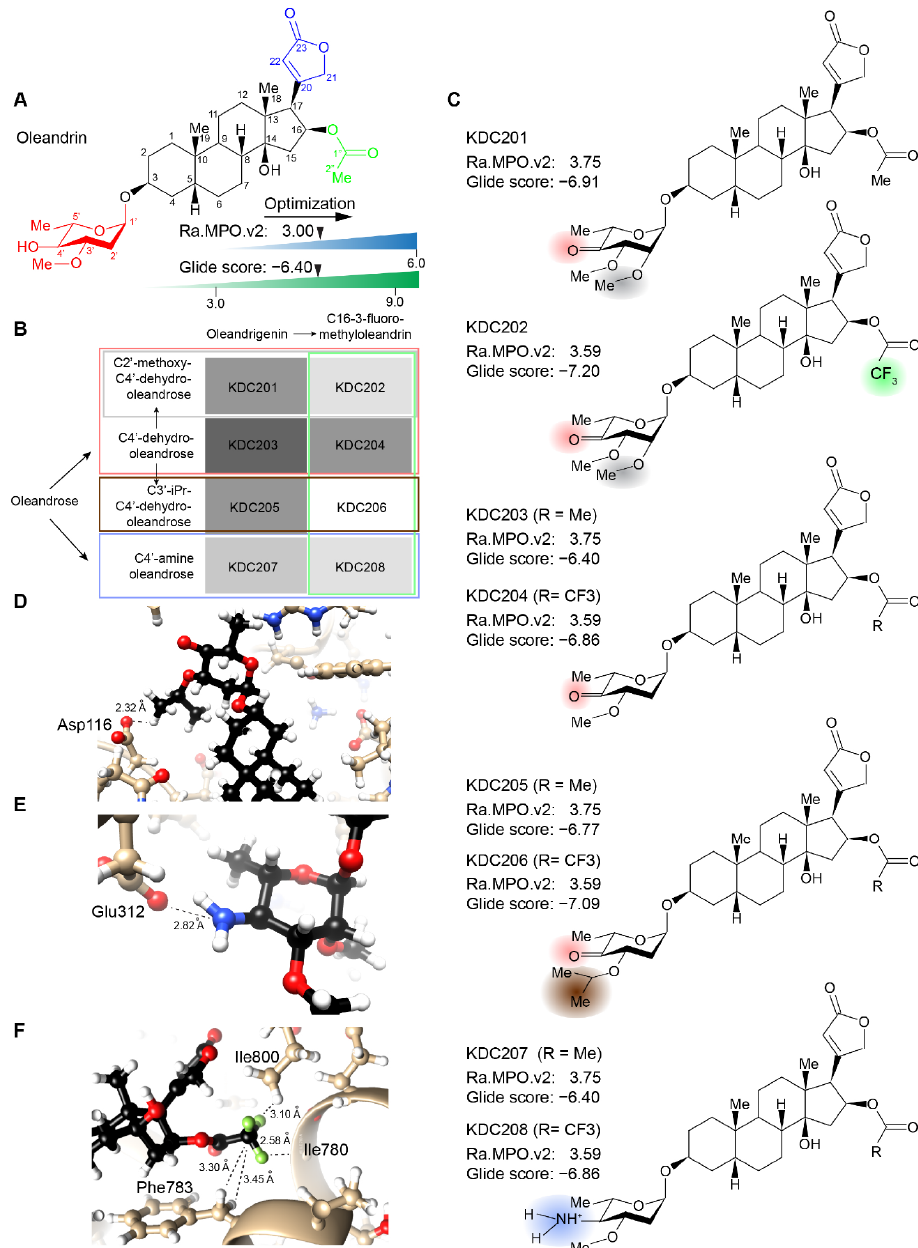
Figure 4. Features of chemically accessible Scaffold 4 derivatives-of-interest. ( A ) Chemical structure and reference Rankovic MPO.v2 and docking scores of oleandrin. ( B ) oleandrin derivatives of interest that should be chemically accessible with good yields in few steps. Starting with oleandrin, several compounds with high predicted Rankovic MPO.v2 scores can be accessed through C4 (cid:48) -dehydro- oleandrin (here termed KDC203) or C4 (cid:48) -amine-oleandrin [49]. ( C ) Chemical structures of compounds listed in Panel B with their respective Rankovic MPO.v2 and Glide scores. Note that structures of KDC204, KDC206 and KDC208 are not depicted. ( D – F ) Close-up models providing plausible explanations for predicted increases of Glide docking scores (residue numbers as in PDB 4HYT). ( D ) Salt bridge between the C4 (cid:48) amine and the sidechain of glutamic acid residue 312. ( E ) Hydrogen bonding opportunity for the C3 (cid:48) isopropyl group with the side chain of aspartic acid residue 116. ( F ) Good fit of C16 trifluoro-acetoxy group within hydrophobic binding pocket shaped from side- chain atoms of phenylalanine 783 and isoleucine 800 residues lining the CG binding pocket. Close-ups were produced with UCSF Chimera (v 1.1.2), San Francisco, CA,